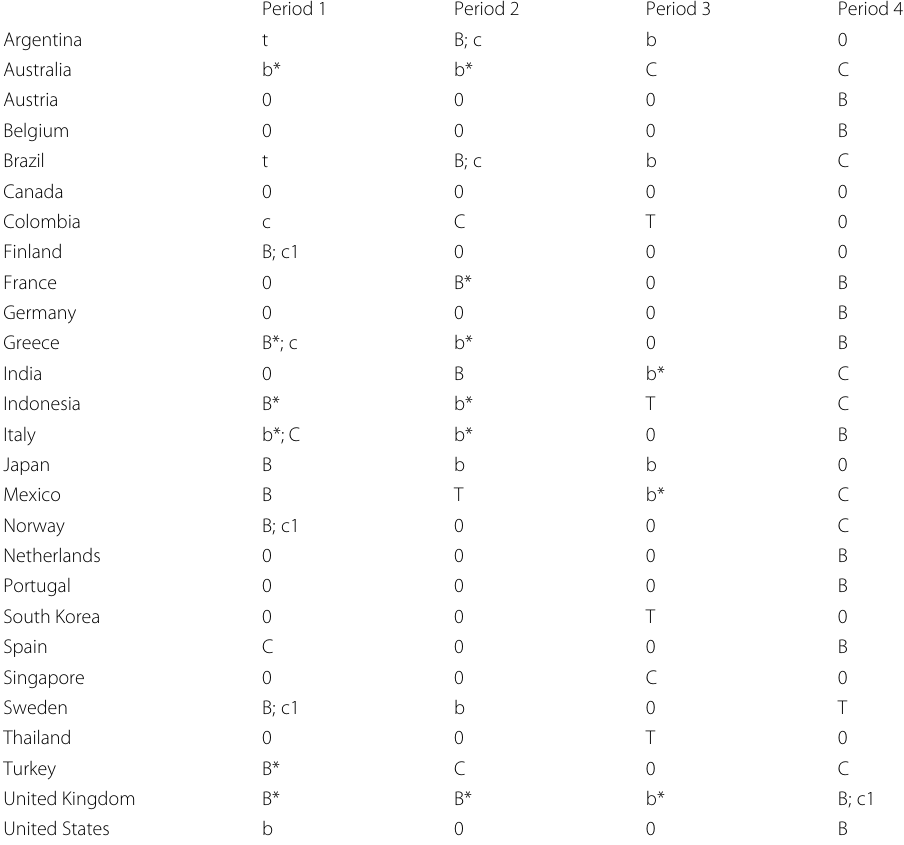
Table 3 Crisis Flagging : Assessment Periods 1-4 Period 1 Period